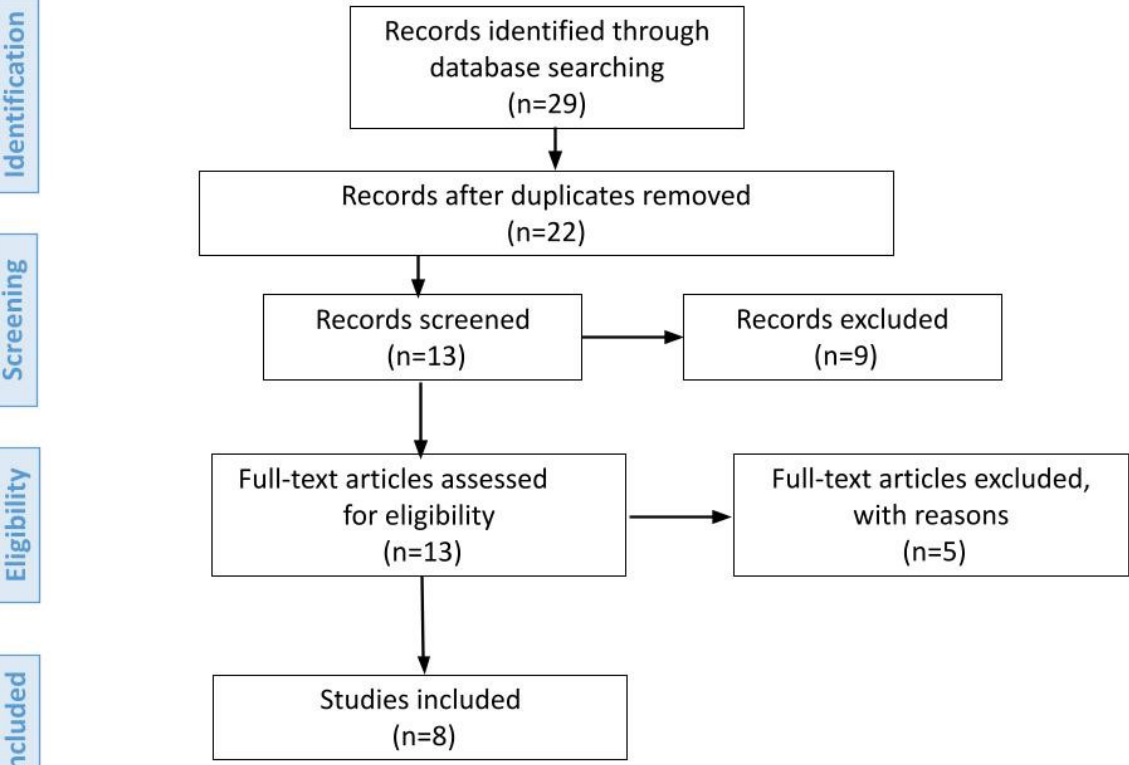
Figure 3. Flow diagram of process of study selection for inclusion in